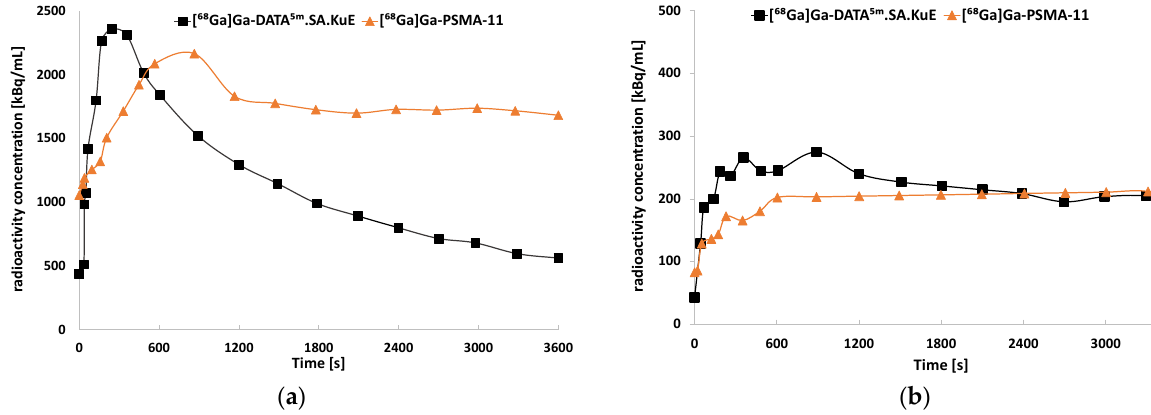
Figure 11. Maximum intensity projections of µ PET scans 1 h p.i. of ( a ) [ 68 Ga]Ga-PSMA-11, ( b ) [ 68 Ga]Ga-DATA 5m .SA.KuE, ( c ) [ 44 Sc]Sc-AAZTA 5 .SA.KuE and ( d ) co-injection of [ 44 Sc]Sc- AZTA 5 .SA.KuE and PMPA (tumor circled).